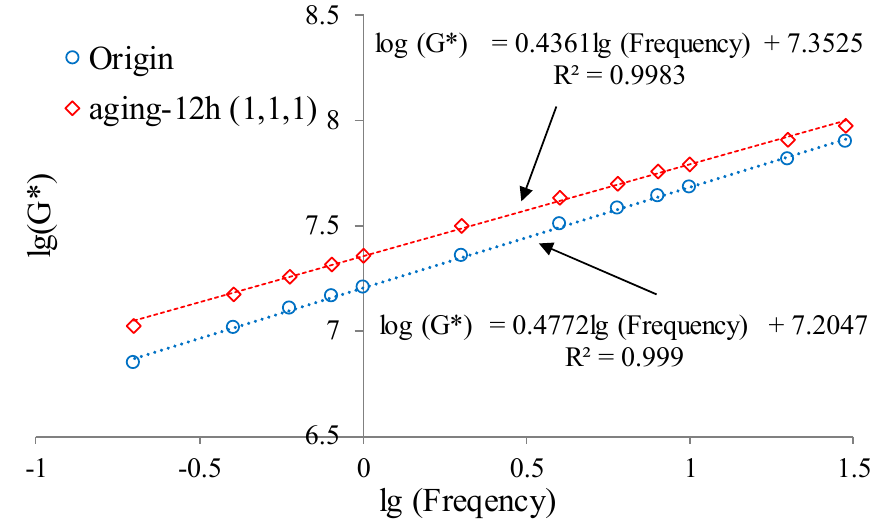
Figure 3. Complex modulus G* versus loading frequency in a log-log coordinate system.